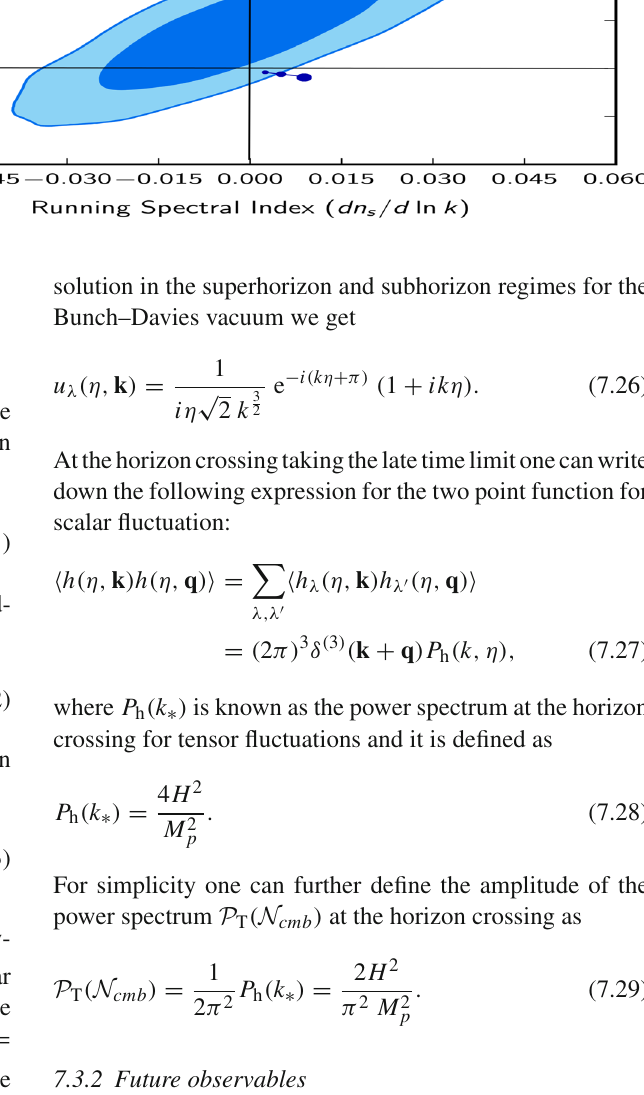
Fig. 9 Plot for running of the running of spectral index κ = d 2 n / d 2 ln k vs. running S S of the spectral index β = d n / d ln k for scalar S S modes. Here for